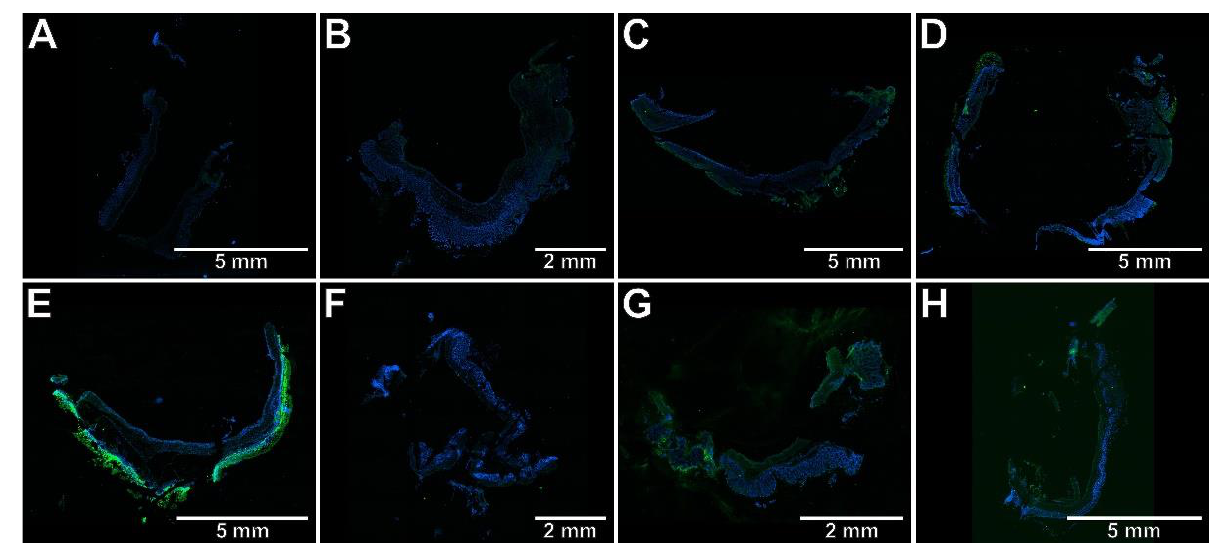
Figure 6. The photomicrographs of cryosections of the whole colon tissue samples after immunostaining with antibodies specific to CCR6 fluorescently detected demonstrated that compounds 7b and 13b counteracted TNBS-induced increase in CCR6 expression. Control group ( A ); group receiving only TNBS ( E ); group receiving 10 mg/kg compound 7b and TNBS ( B ); group receiving 20 mg/kg compound 7b and TNBS ( F ); group receiving 10 mg/kg compound 10b and TNBS ( C ); group receiving 20 mg/kg compound 10b and TNBS ( G ); group receiving 10 mg/kg compound 13b and TNBS ( D ); group receiving 20 mg/kg compound 13b and TNBS ( H ); magnification 4×.